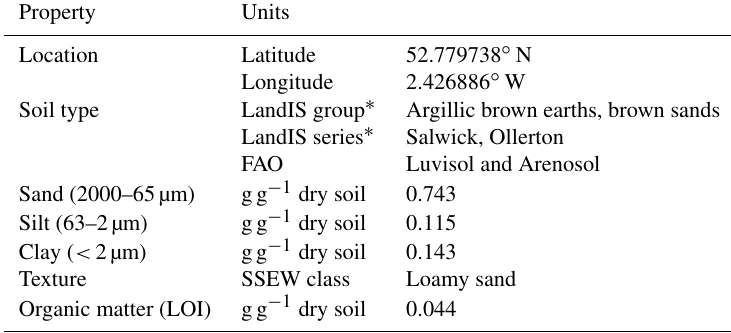
Table 1. Description of the topsoil (0–300mm) properties for the Harper Adams University trial site, Shropshire,